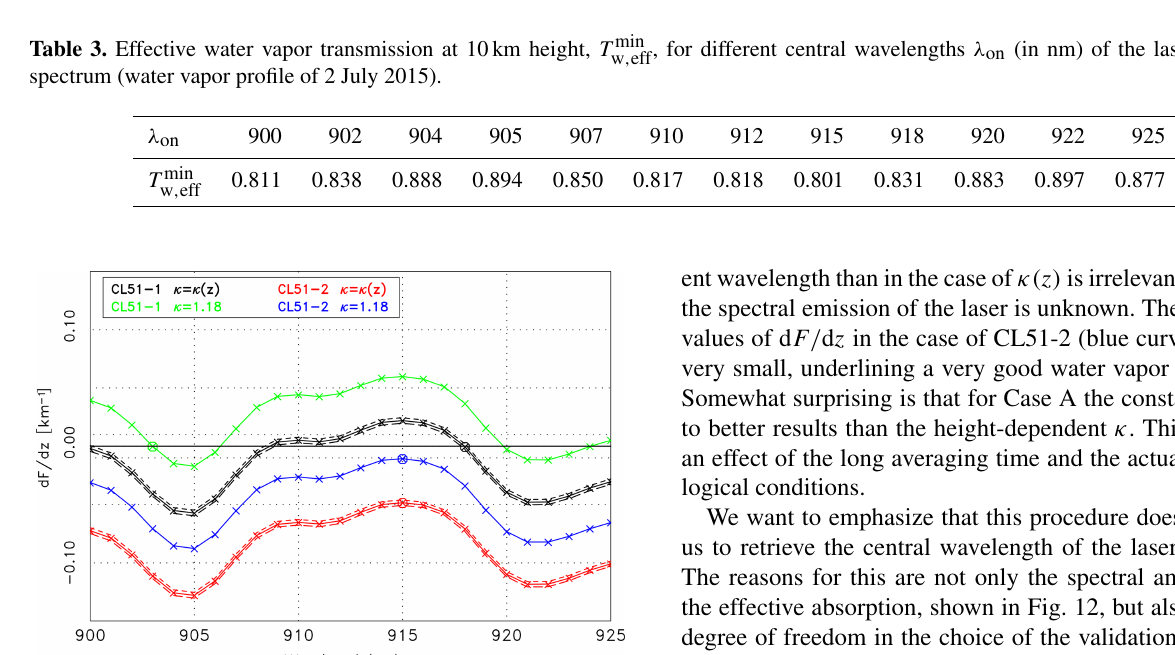
, for different central wavelengths λ on (in nm) of the laser emission w , eff